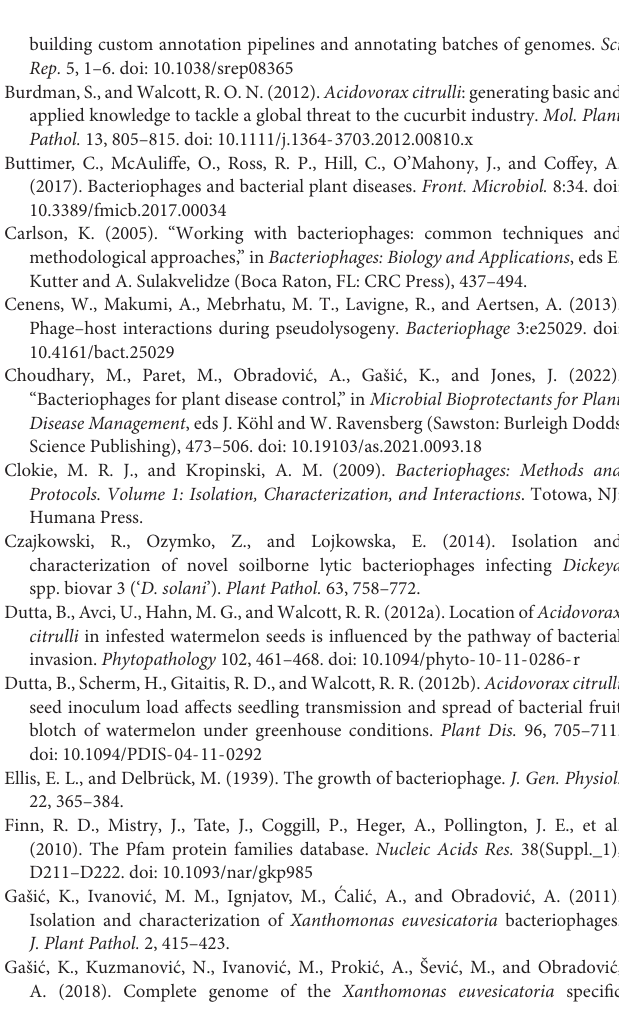
Supplementary Figure 1 | Restriction DNA profiles of Acidovorax phage ACF1, ACF8, and ACF12 after digestion with enzymes Eco RI and Bam HI, M1 – Lambda DNA/ Eco RI + Hin DIII Marker (Thermo Fisher, Lithuania), M2 – GeneRuler DNA Ladder Mix (Thermo Fisher, Lithuania). Supplementary Figure 2 | Automated classification of Acidovorax phage ACF1 according to its neck organization by Virfam analysis (Lopes et al., 2014). The different branches of the tree were sorted into 10 Clusters, highlighted by different background colors and numbers. Supplementary Table 1 | Putative open reading frames (ORFs) of Acidovorax phage ACF1, their predicted functions and detected conserved